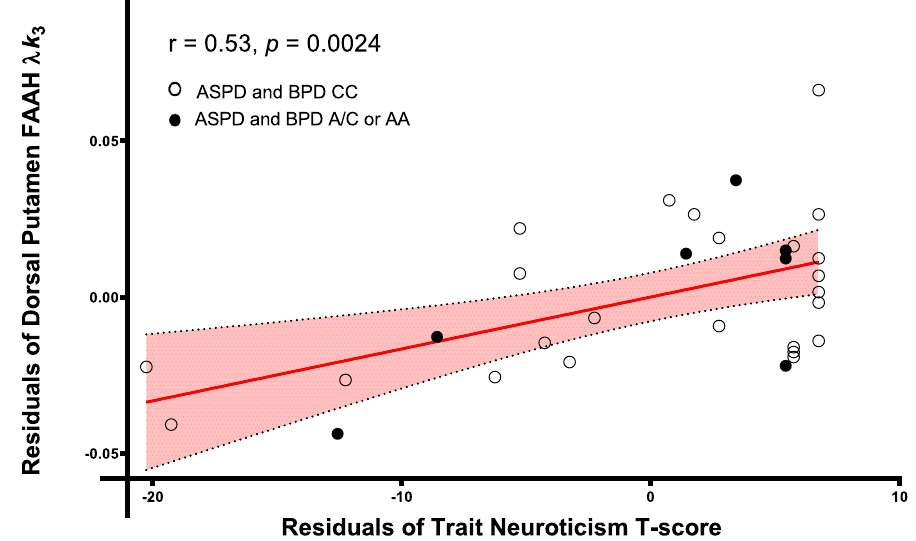
Figure 2. Dorsal putamen fatty acid amide hydrolase λ k 3 is correlated with trait neuroticism ( T score) controlling for genotype in antisocial and borderline personality